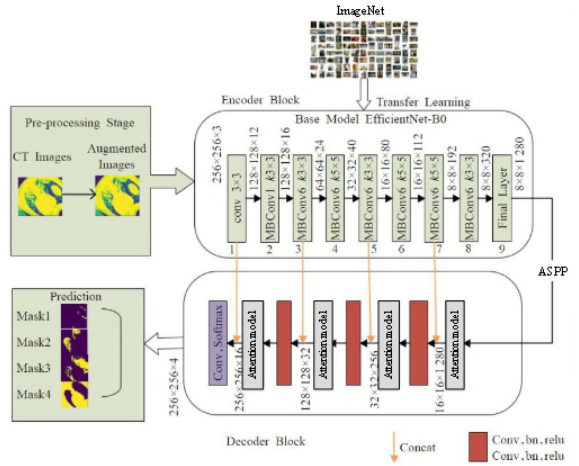
Fig. 1. Proposed medical image segmentation